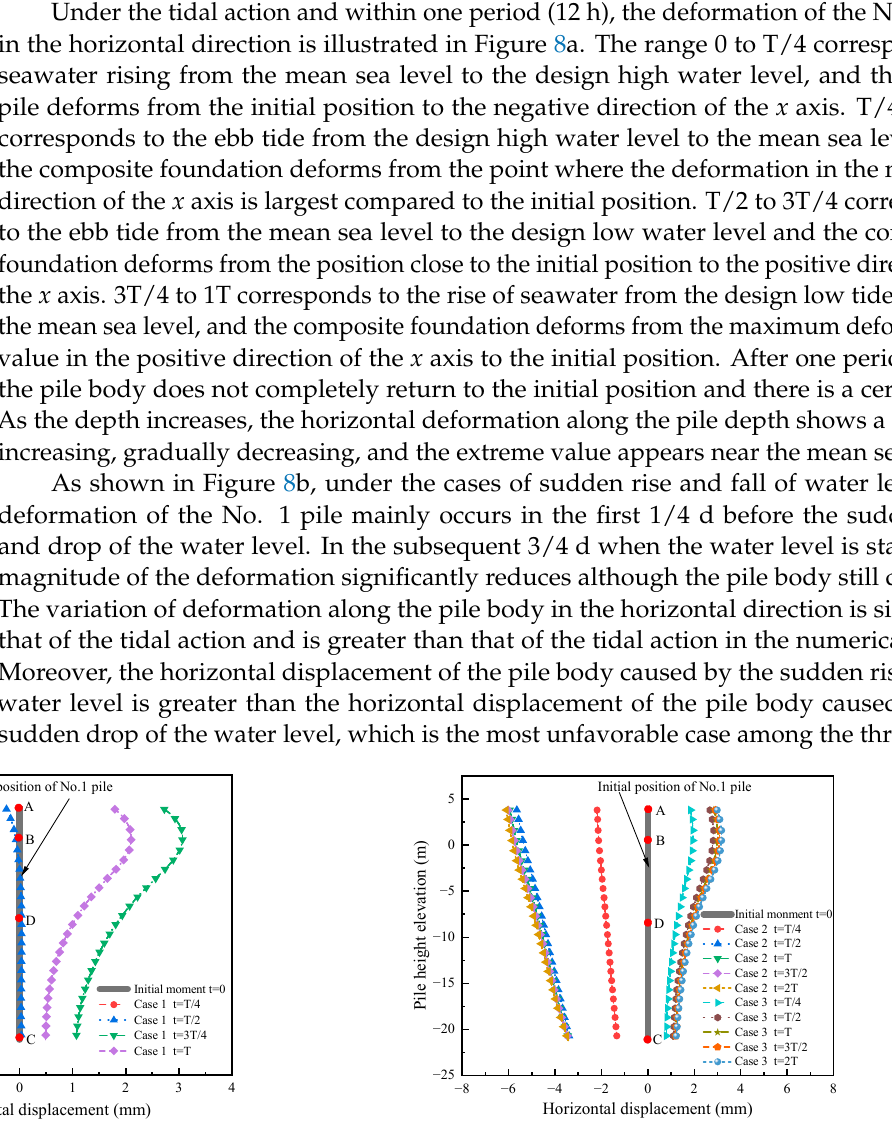
Horizontal displacement (mm)